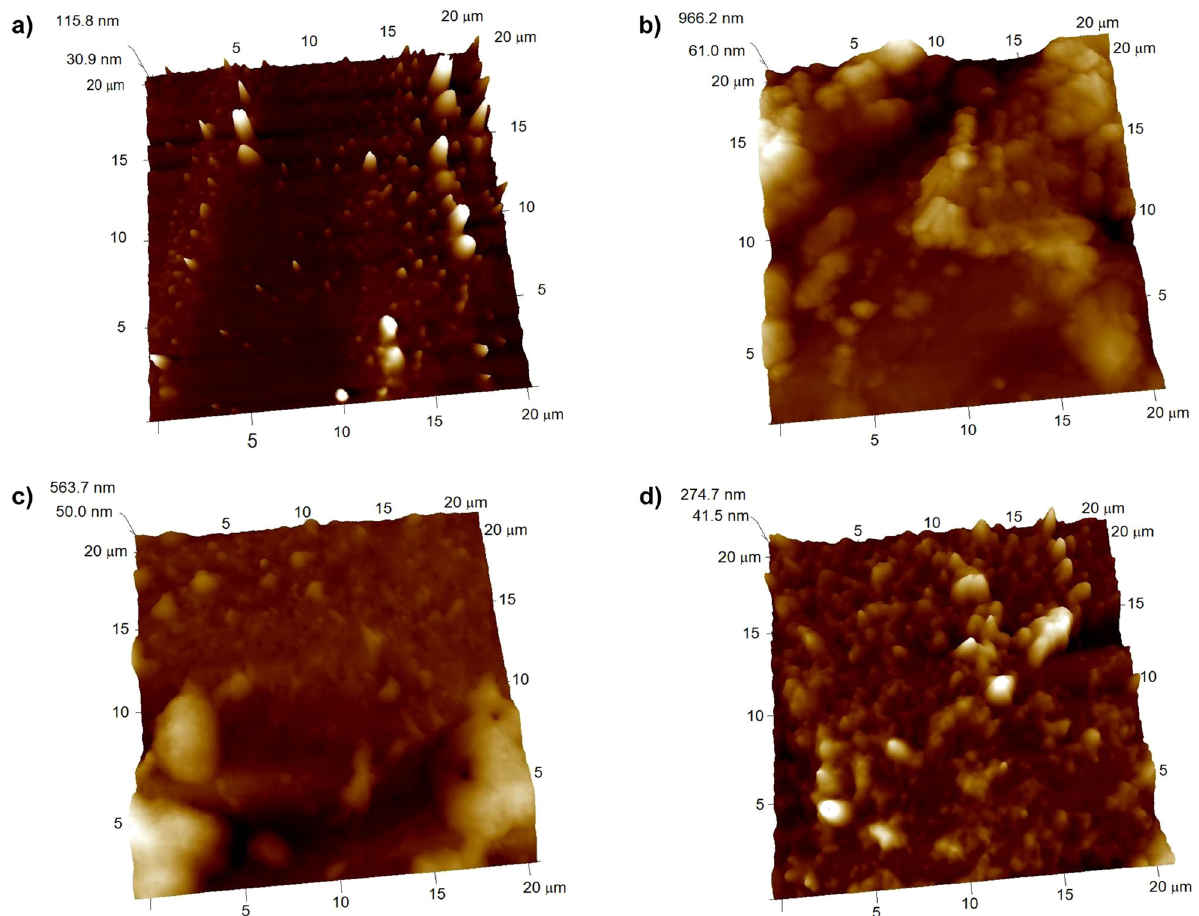
Fig. 6 AFM images of untreated PU and PEG-grafted PU fi lms. a PU, ( b ) PU-PEG 0.05, ( c ) PU-PEG 0.10, ( d ) PU-PEG